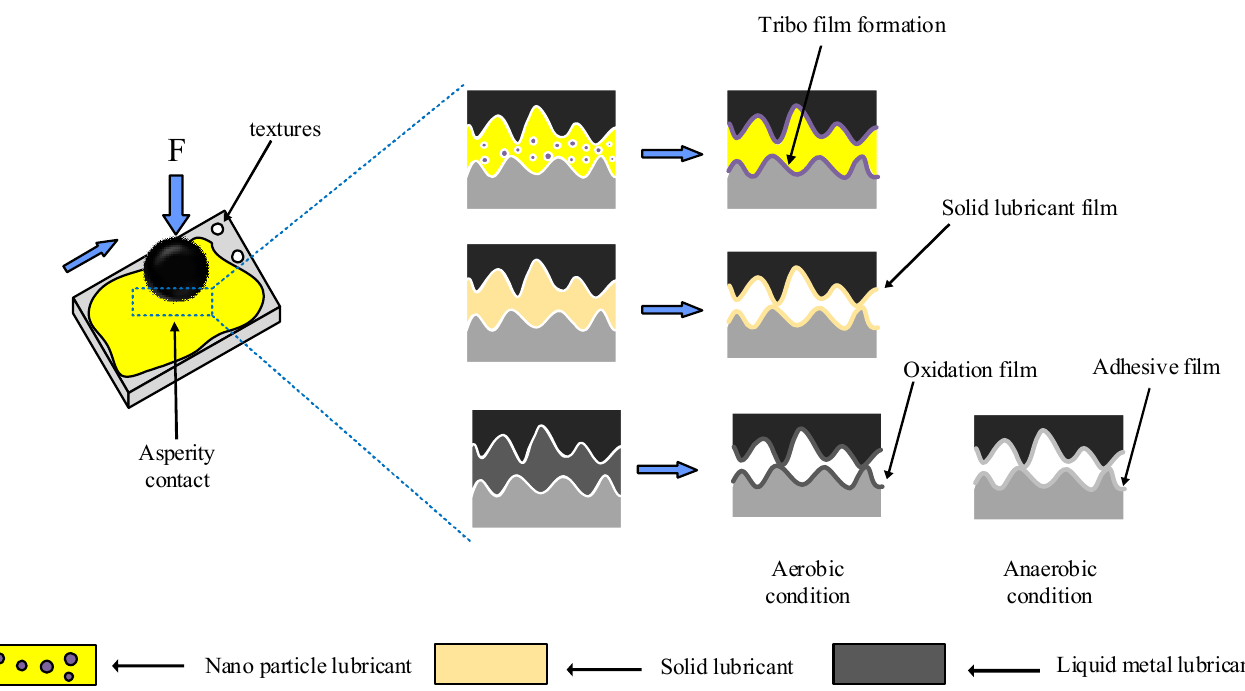
Figure 10. Schematic of the proposed lubrication mechanism of nanoparticle lubricants, solid lubri- cants, and liquid metal lubricants.